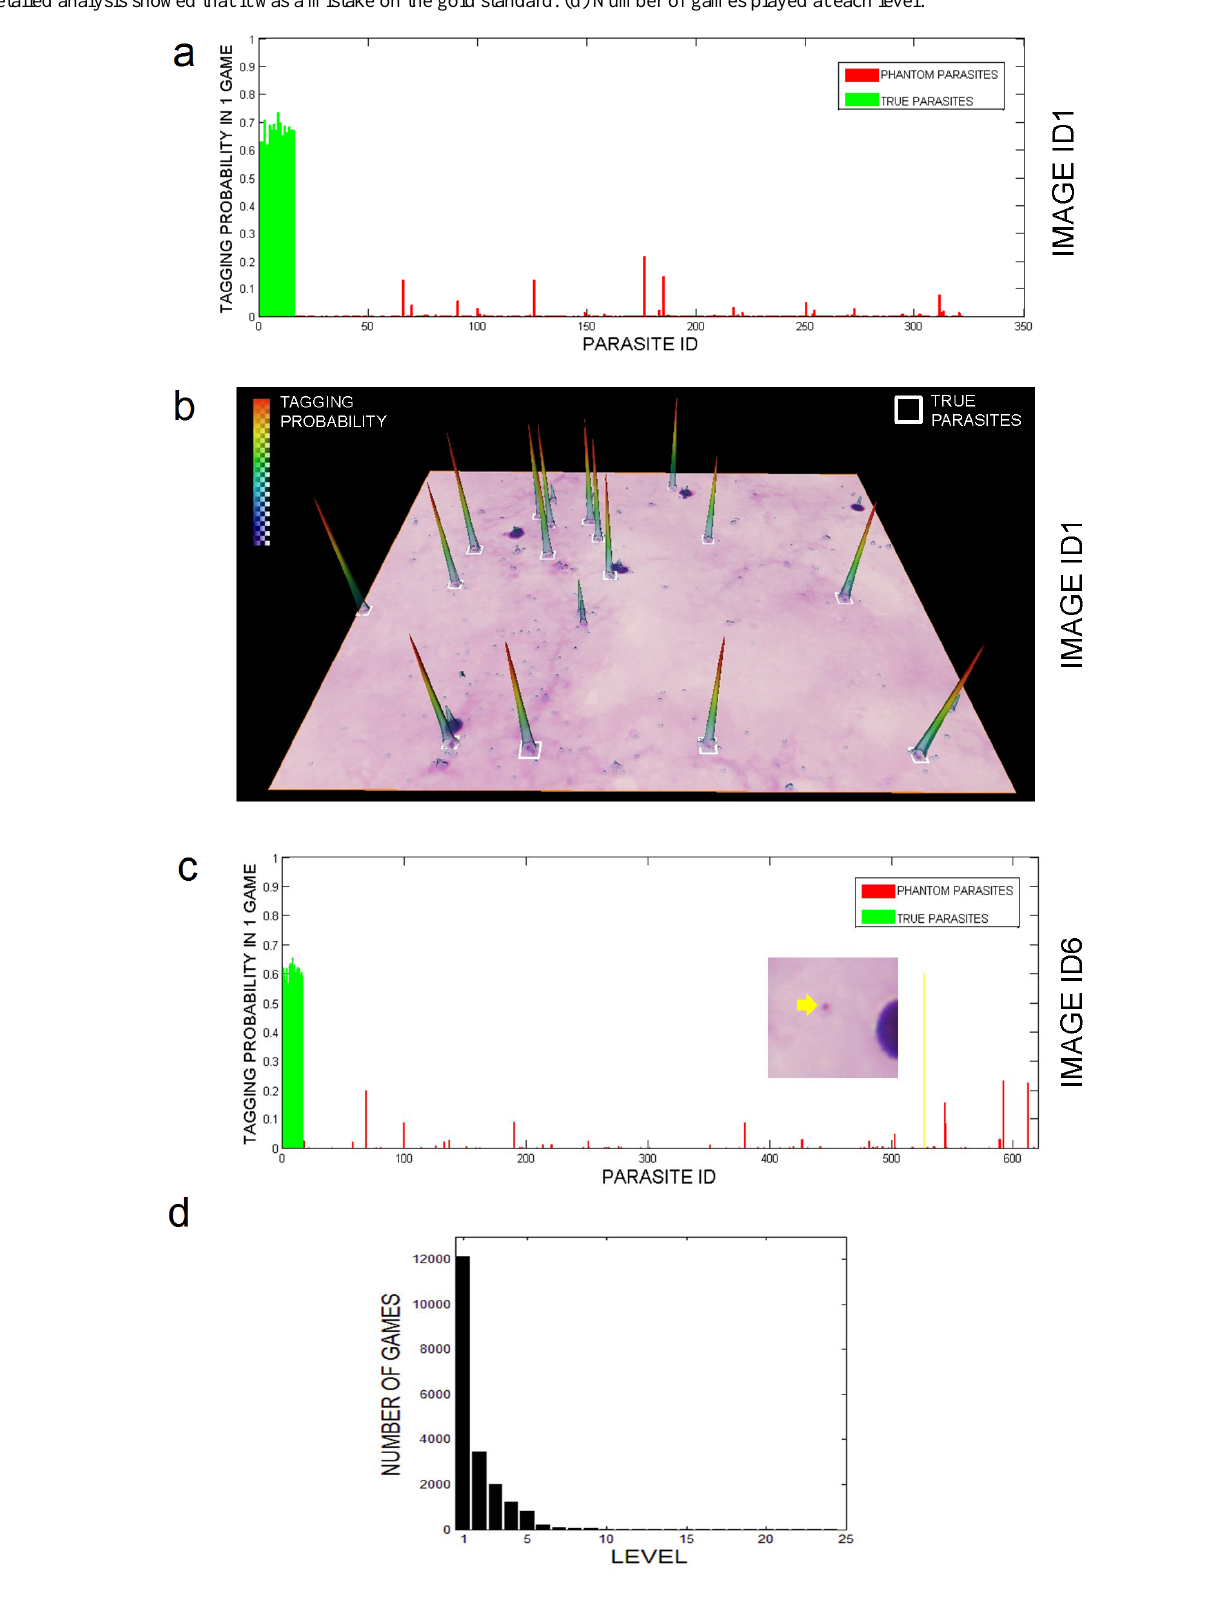
Figure 4. Individual gamer’s performance. (a) Tagging probability for true parasites and phantom parasites on image ID1 based on all games. (b) Tagging probability field superimposed on raw image. True parasites (gold standard) are signaled by white squares. (c) Aggregated tagging probability for true parasites and phantom parasites on image ID6. Note that the probability of the phantom parasite (tagged in yellow) is as high as the true parasites. Detailed analysis showed that it was a mistake on the gold standard. (d) Number of games played at each